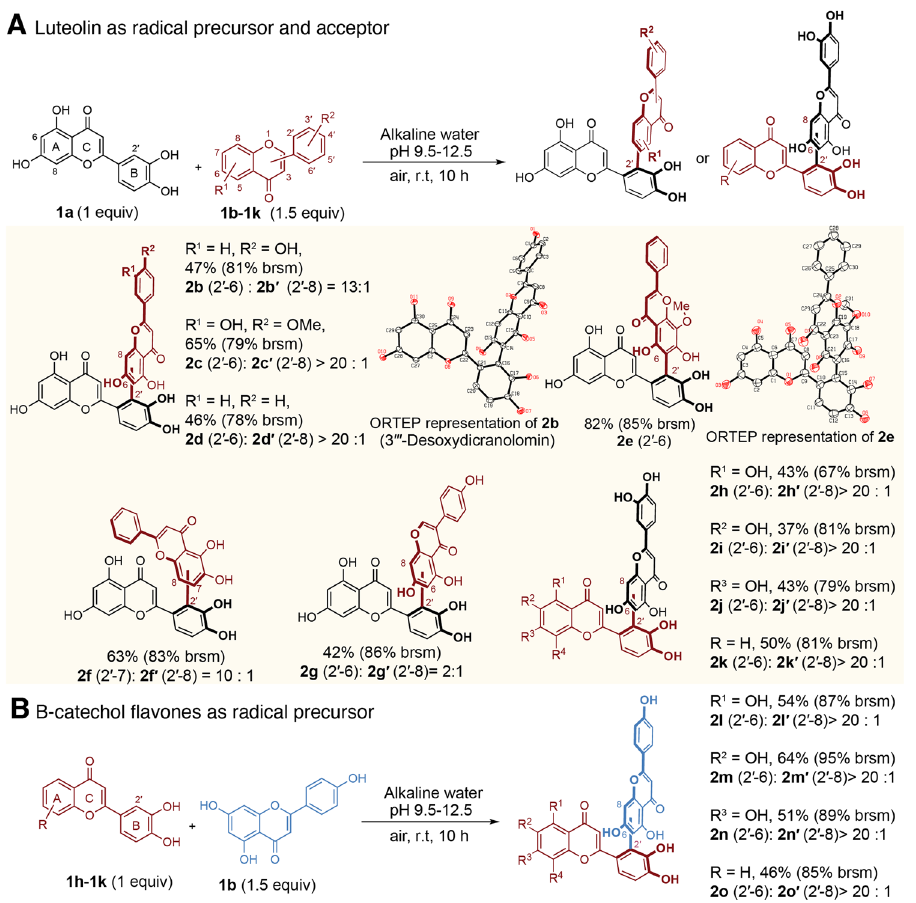
Fig. 4 | Thesubstratescopeofoxygen-mediatedcross-coupling ofluteolin and fl avones.A luteolinasaradicalprecursorandacceptor,andrelatedproducts,with ORTEP representations for compounds 2b and 2e . B B-catechol fl avones as radical